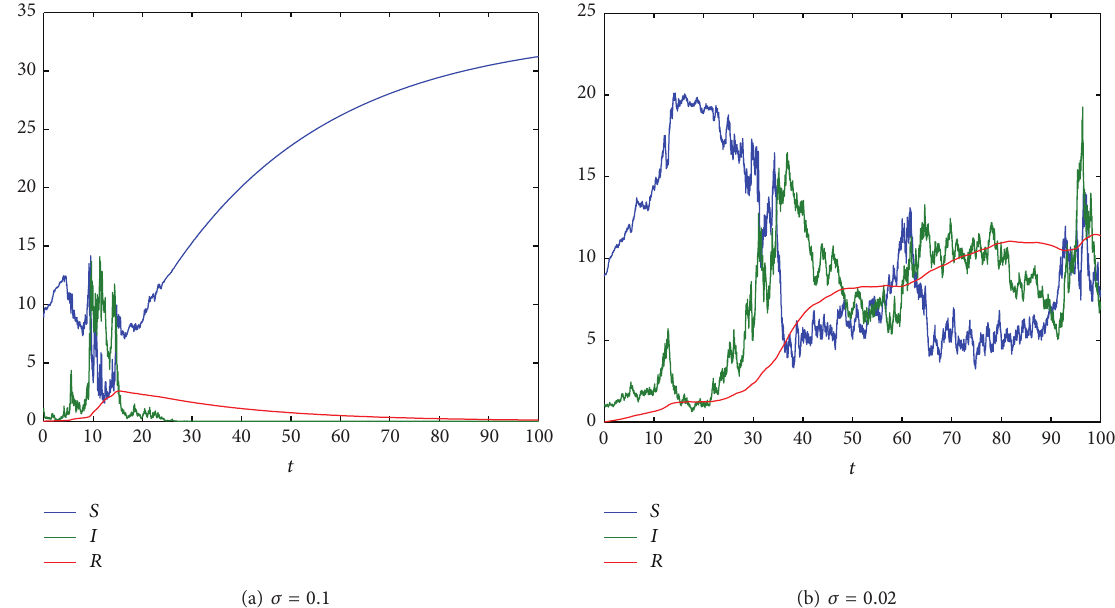
Figure 2: The paths of 𝑆(𝑡) , 𝐼(𝑡) , and 𝑅(𝑡) for the stochastic model (3) with initial values (𝑆(0),𝐼(0),𝑅(0)) = (9,1, 0) . The parameters are taken as (41) ( 𝑅 0 = 7.407